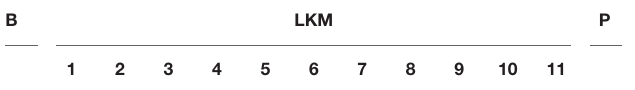
TABLE 1 | Mean percentages of accepted segments for each minute, resting-state baseline (B) each minute (1–11) of the audio exercise (LKM) and the post-induction resting-state baseline (P).